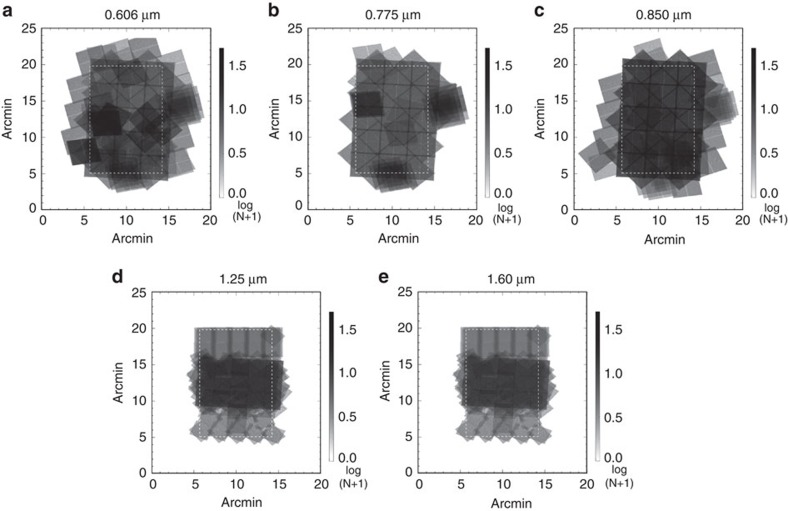
Summary of tile patterns and their data archive identifications.(a) Proposal ID's for each filter in the GOODS-S field. The ACS and WFC3 rows show the proposals which are common between all the bands in each instrument. For each proposal we did not necessarily use all the frames, specifically those from deep surveys. Also show are the tiling patterns for all the bands: 0.606 μm (F606W); (b) 0.775 μm (F775W); (c) 0.850 μm (F850LP); (d) 1.25 μm (F125W); (e) and 1.60 μm (F160W); (f) The units of the tile pattern figures are log10(N+1), where N is the number of frames overlapping. The dashed white line indicates the cropped region where the fluctuation analysis was performed.